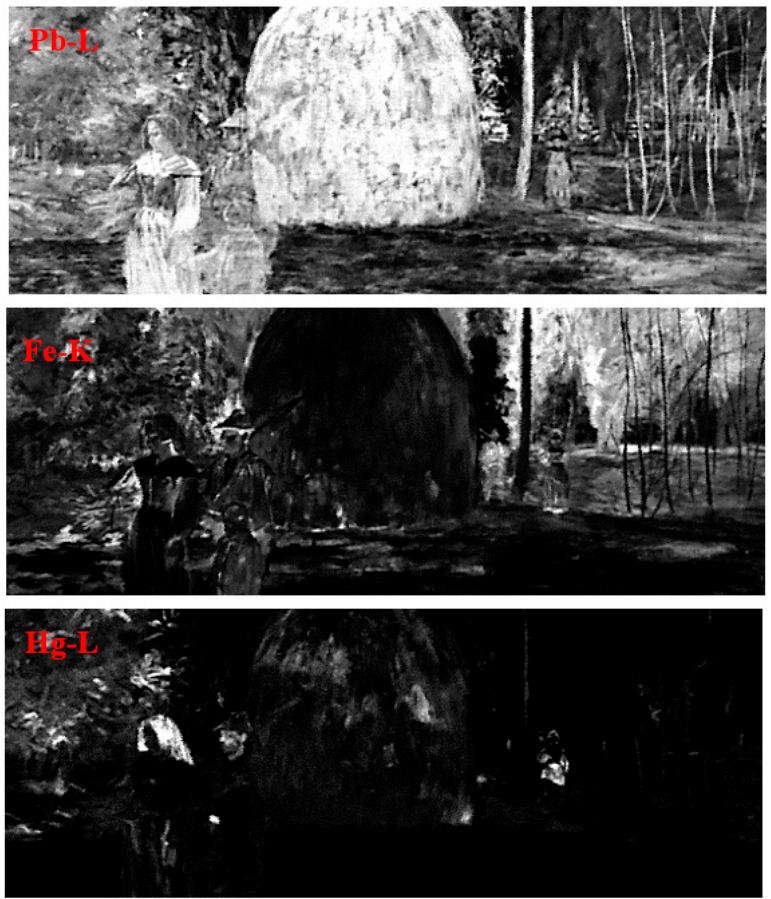
Figure 6. Pb-L, Fe-K, and Hg-L elemental maps of painting “ Volta do trabalho ” by Henrique Bernadelli. The images were obtained from a 65 cm × 45 cm region of the painting.